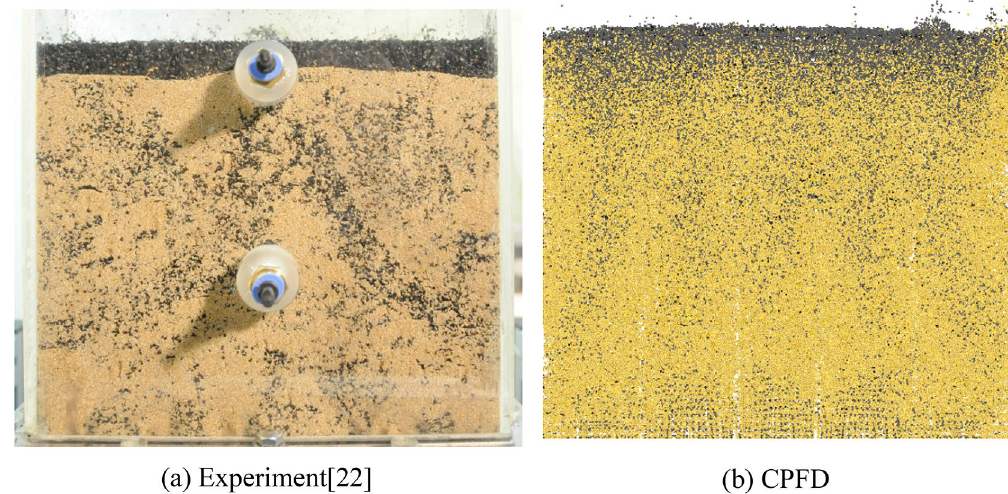
Figure 5. Behavior of char particle in a bubbling fluidized bed at U/Umf =